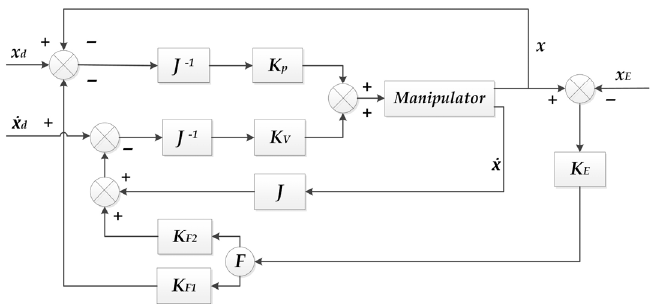
Figure 1. Impedance control scheme structure diagram. (Stiffness matrix K p , damping coefficient matrix K v , stiffness feedback matrix K F 1 and damping feedback matrix K F 2